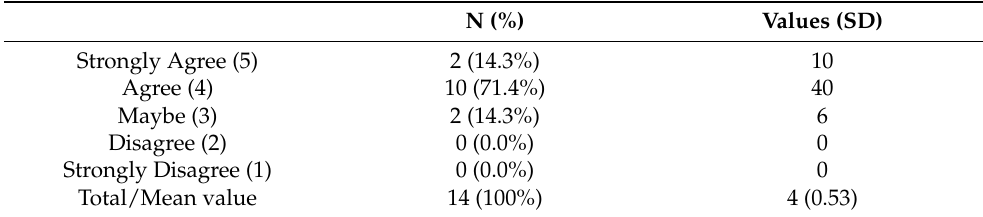
Table 2. Does your hotel take into account environmental issues (Q3). N (%) Values (SD) Strongly Agree (5) 2 (14.3%) 10 Agree (4) 10 (71.4%) 40 Maybe (3) 2 (14.3%) 6 Disagree (2) 0 (0.0%) 0 Strongly Disagree (1) 0 (0.0%) 0 Total/Mean value 14 (100%) 4 (0.53)